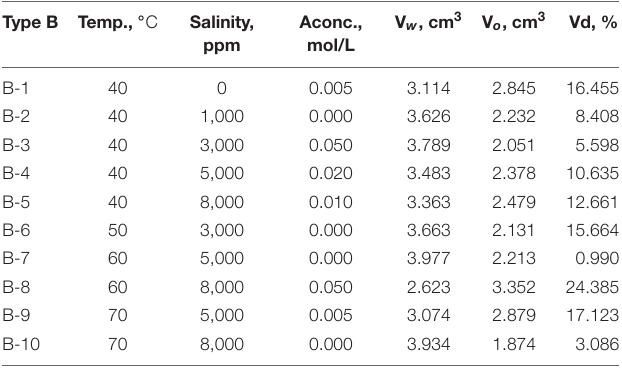
TABLE 2 | NaOH orthogonal test phase migration volume fraction of 2-phase distribution cases.